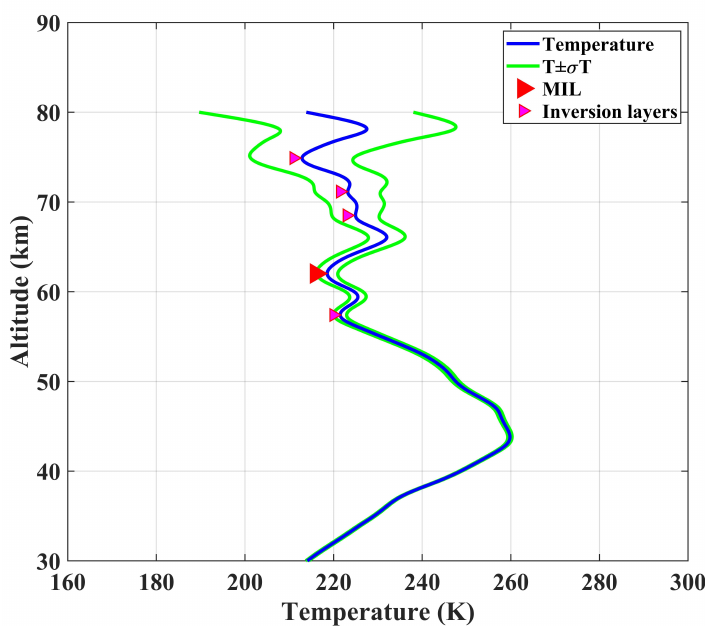
Figure 3. Temperature profile illustrating the detection of different atmospheric layers that could be associated with a MIL on 4 January 2000. The measurement uncertainty for the temperature profile is indicated by the green lines. Potential MILs’ minimum altitudes are indicated by the red and pink triangles. The red triangle corresponds to the bottomside of the layer, which passed all tests and was classified as an